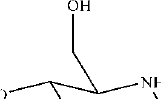
Figure 2. Effect of DNJ on the levels of serum triglyceride (TG) ( a ); total cholesterol (TC) ( b ); low density lipoprotein cholesterol (LDL-C) ( c ); high density lipoprotein cholesterol (HDL-C) ( d ) and liver TG content ( e ) in db/db mice. ## p < 0.01 vs. normal control. * p < 0.05, ** p < 0.01 vs. db/db control, @ p < 0.05,